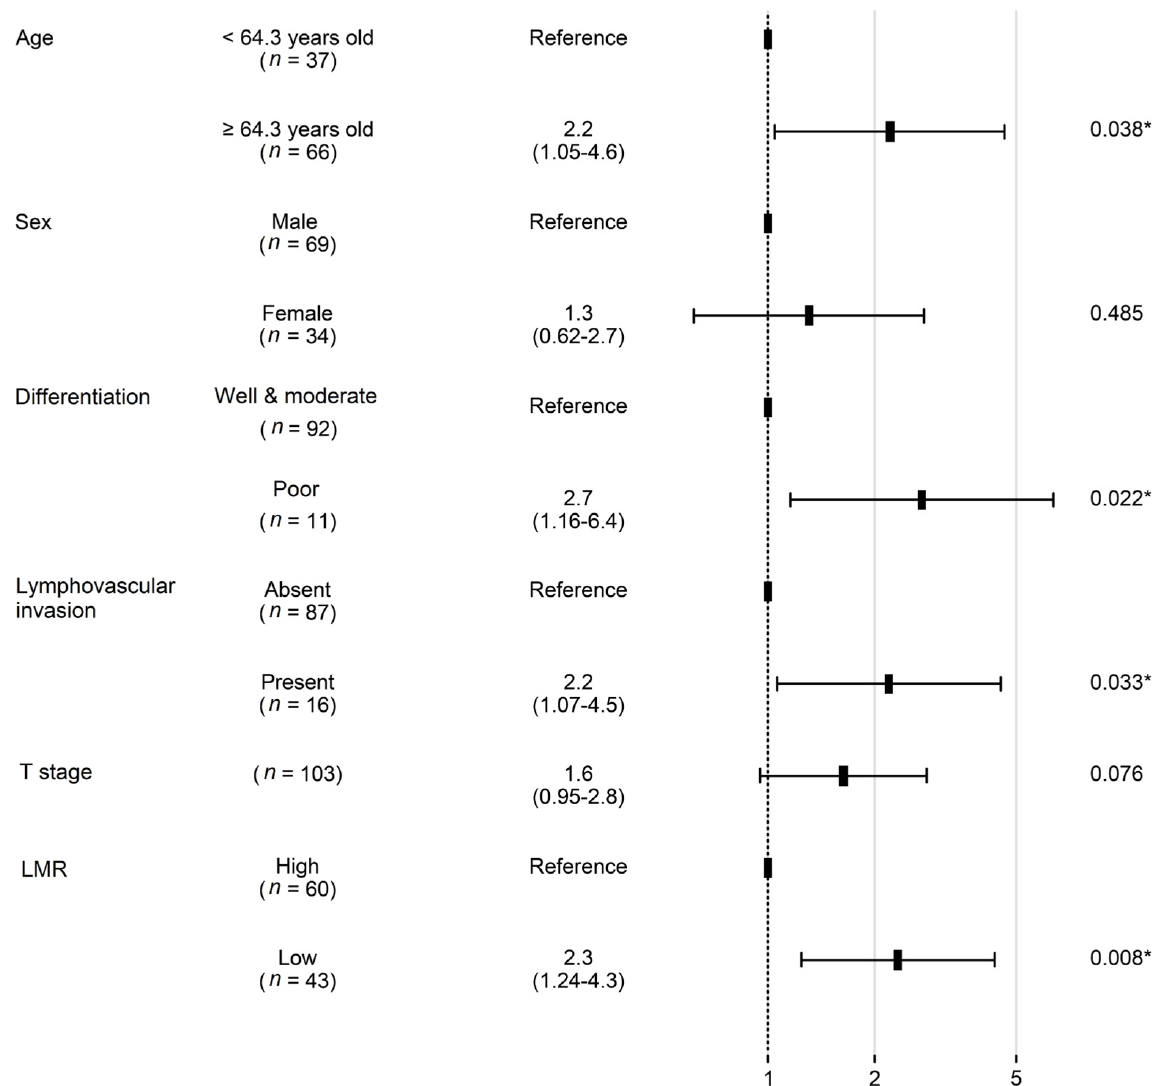
Figure 5. Forest plot showing hazard ratios obtained by multivariate Cox regression for overall survival in patients with stage I/II non-small cell carcinoma. LMR—lymphocyte–monocyte ratio. * Indicates factors with significant p values.